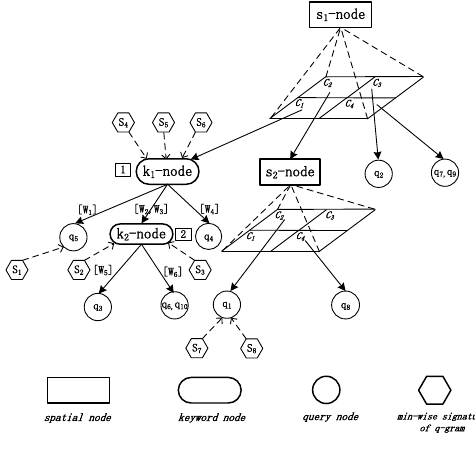
Figure 2. An example of AP-tree +